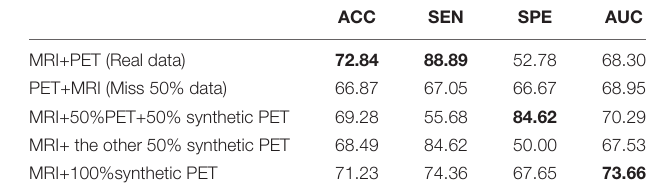
TABLE 6 | Diagnosis results (%). ACC SEN